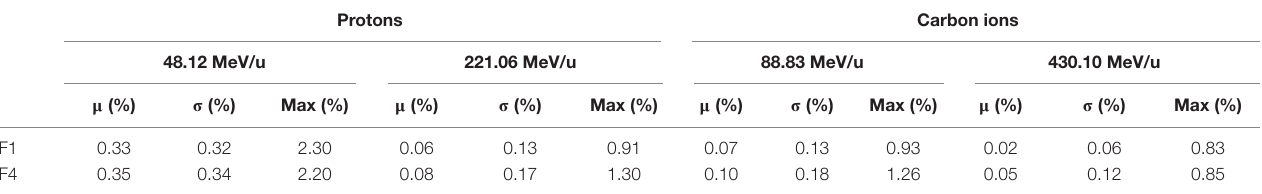
FigUre 4 | energy spectra difference for protons and carbon ions at the isocenter in air: on the left panels, absolute differences in primary spectra obtained with the Ps and Bl approaches are displayed for foci 1 and 4 (blue and red) together with the primary spectra shape (in black, similar for foci 1 and 4 and both approaches); on the right panel, secondary spectra at isocenter are displayed for the beamline approach (narrow beam and focus 1) and the Ps approach; the upper panels correspond to protons, energy 48.12 MeV/u, and the bottom panels correspond to carbon ions, energy 88.83 MeV/u TaBle 1 | Primary particle fluence differences at the isocenter (absolute global differences with mean μ , sD σ , and maximum value) between the Ps and the Bl approaches for both foci 1 and 4 for the vertically integrated lateral profile distributions, in percentages compared to the maximum fluence and in a zone of interest with an fluence > 0.01% of the maximum one.